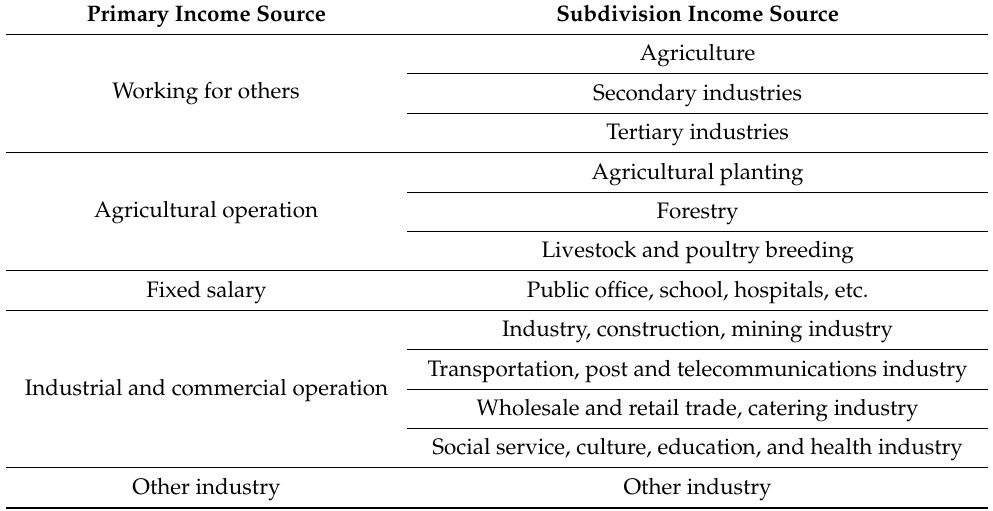
Table 2. Household income